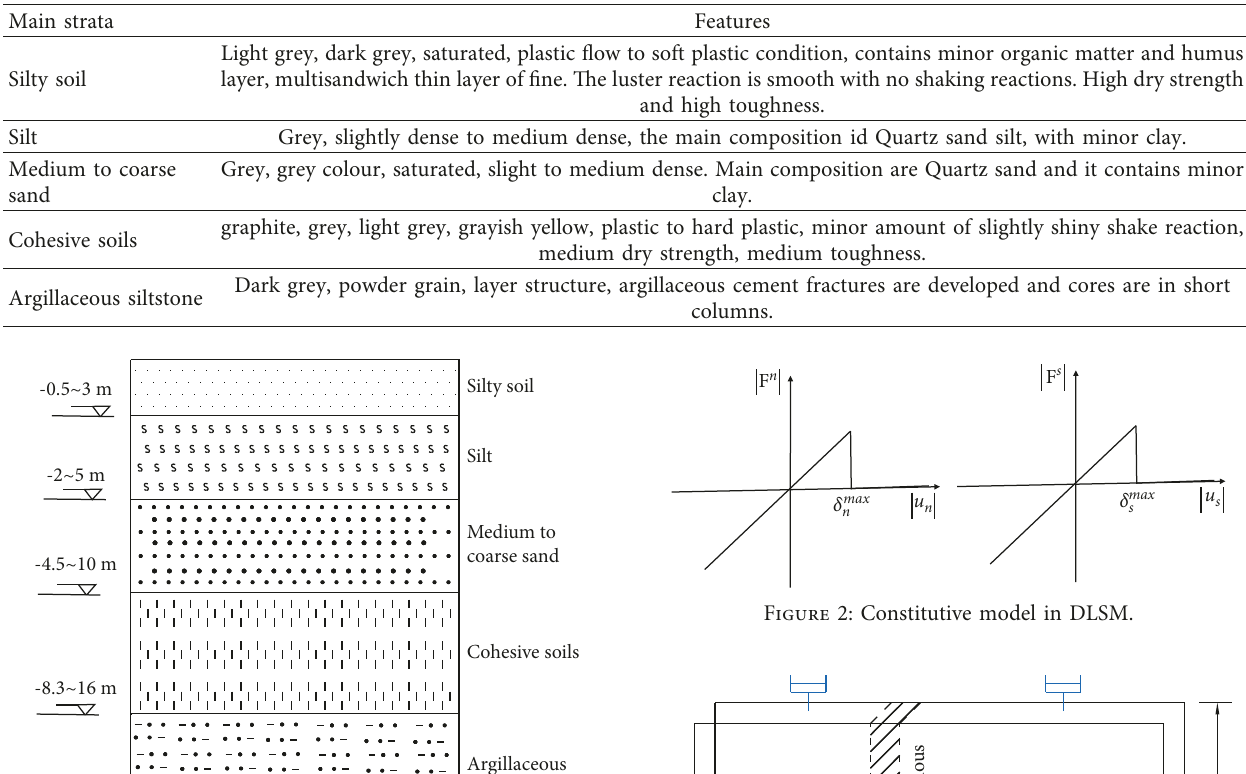
Figure 2: Constitutive model in DLSM.